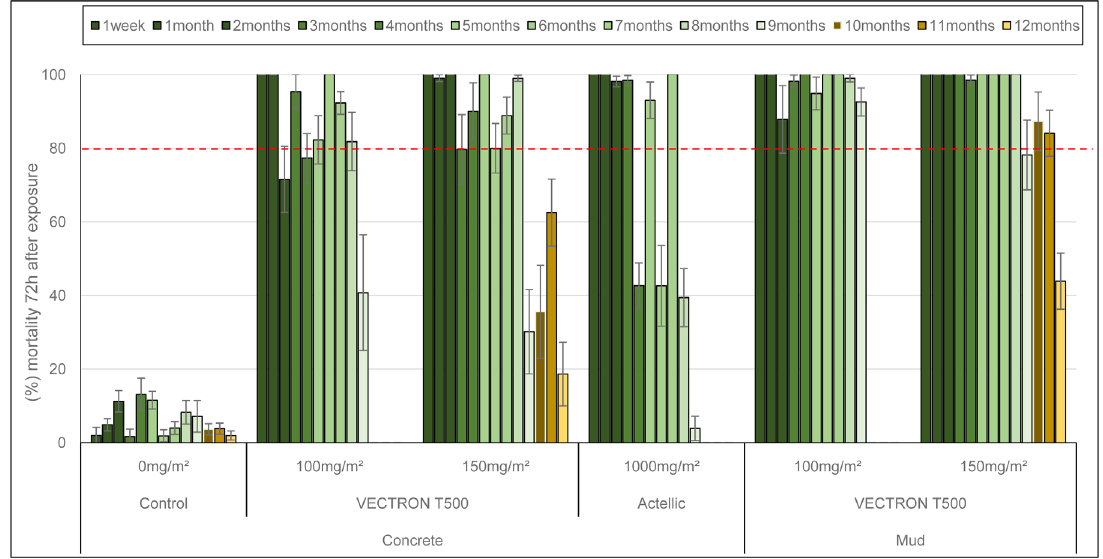
Figure 5. Mortality of Anopheles coluzzii pyrethroids resistant strain exposed to treated huts surfaces in cone bioassays. Approximately 100 mosquitoes 2–5 days old were exposed for 30min contact to the treated hut walls and ceiling, and mortality recorded 72 hours after exposure. Overall, 10 cones per hut, two per side and 10 mosquitoes per cone were used at each time point. Each histogram represents the mean mortality rate of tested mosquitoes at each time point and error bars represent ± 95% confidence interval (CI). The dotted line represents World Health Organization (WHO)